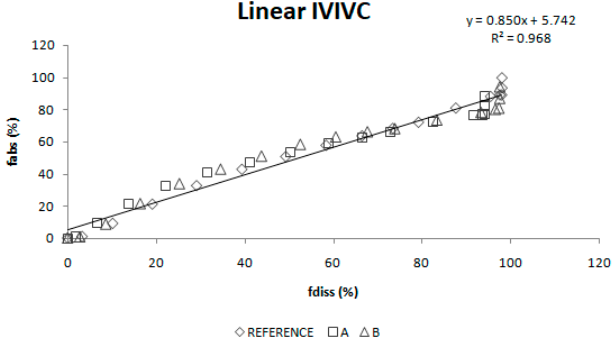
Pharmaceutics 2020 , 12 , x 14 of 22 Figure 9. Linear two-step in vitro-in vivo correlation. Figure 9. Linear two-step in vitro - in vivo correlation.